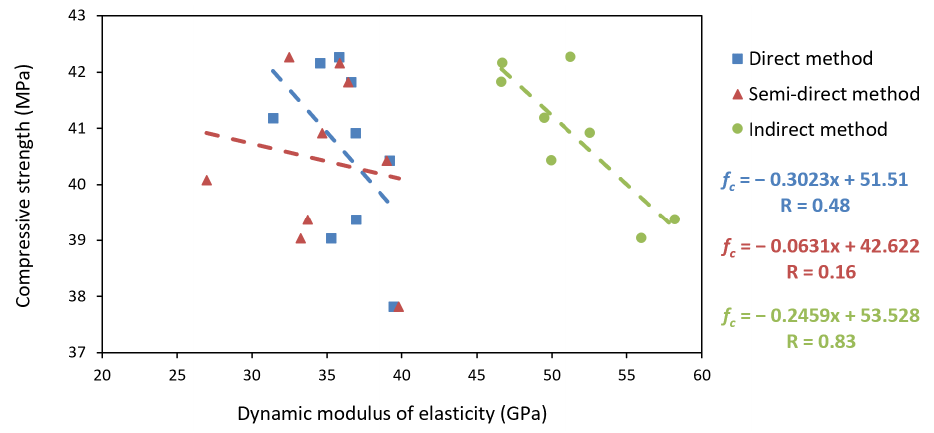
Figure 16. Correlation between the dynamic modulus of elasticity and compressive strength.